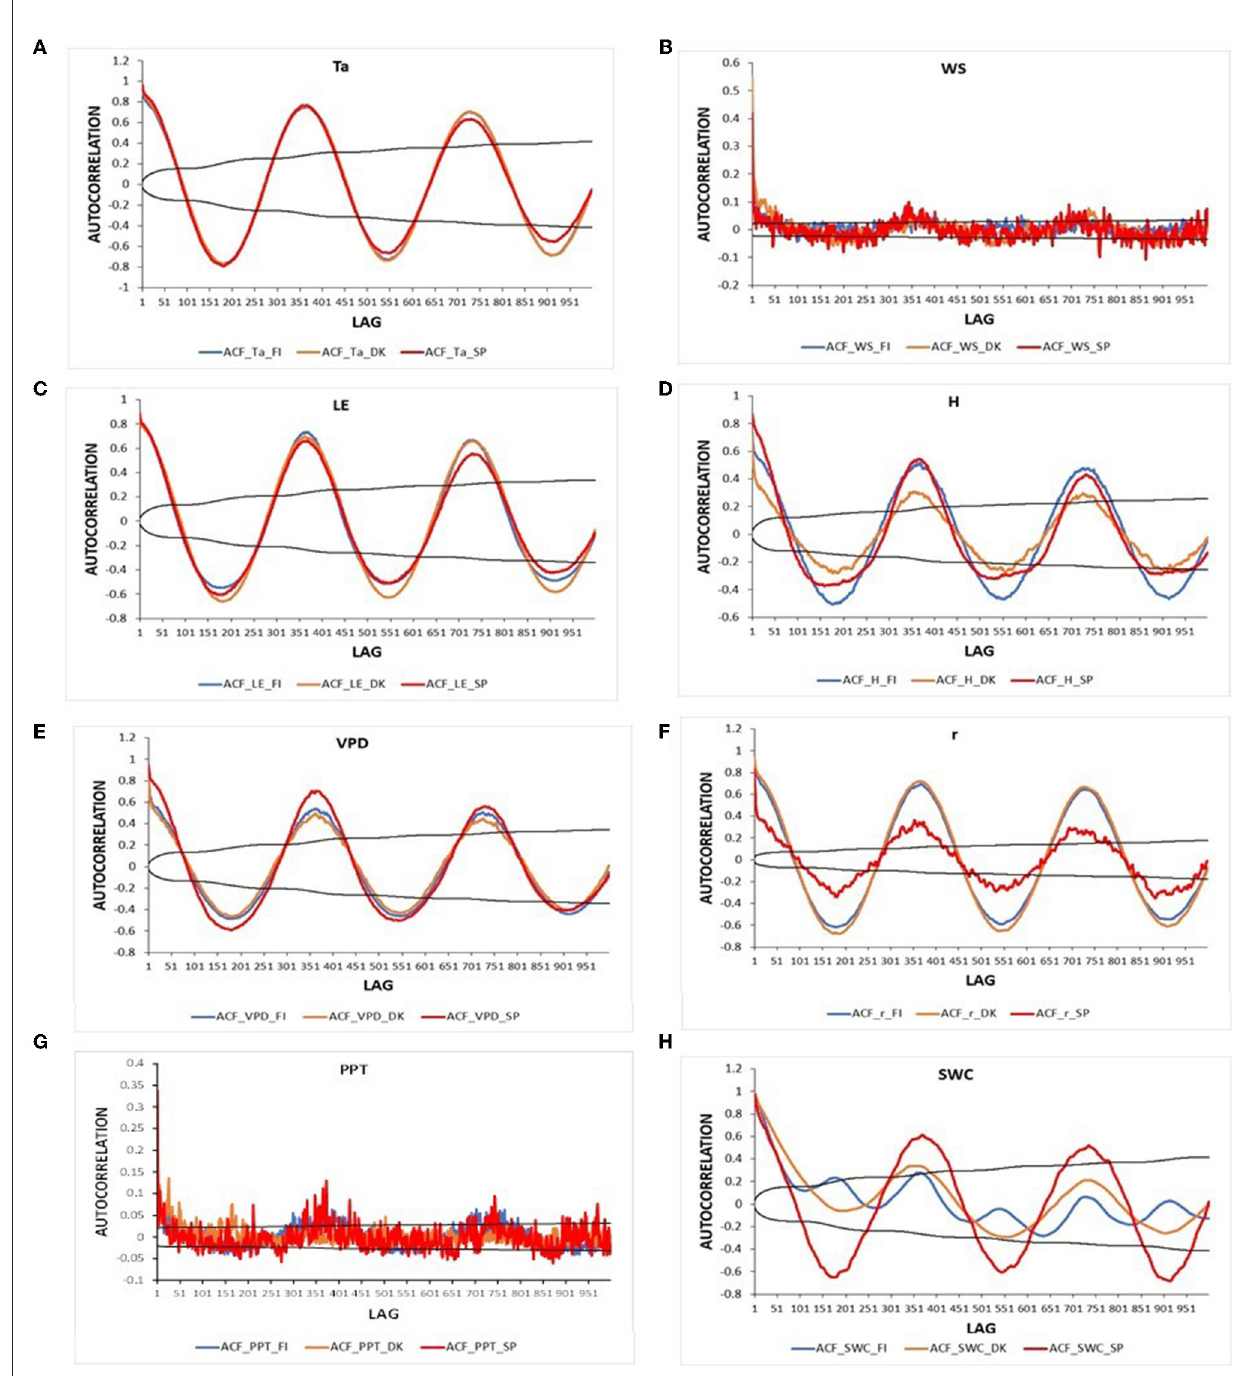
FIGURE5 Autocorrelation of the daily meteorological and energy fluxes variables for the study period in the three European ecosystems [Evergreen Needleleaf Forest of Finland (ENF_FI, blue line), Deciduous Broadleaf Forest of Denmark (DBF_DK, orange line), and Mediterranean Savanna ecosystem of Spain (SAV_SP, red line)]: (A) Air temperature (Ta) ( ◦ C), (B) Wind speed (WS) (m s − 1 ), (C) Latent heat flux (LE) (W m − 2 ), (D) Sensible heat flux (H) (W m − 2 ), (E) Vapor pressure deficit (VPD) (hPa), (F) Mixing ratio (r) (g kg − 1 ) (G) Precipitation (PPT) (mm day − 1 ), and (H) Soil water content (SWC) (% vol). The black lines represent the interval of confidence in the autocorrelation